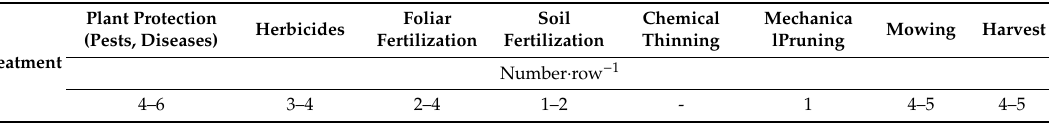
Table 5. Number of agrotechnical and chemical in plum